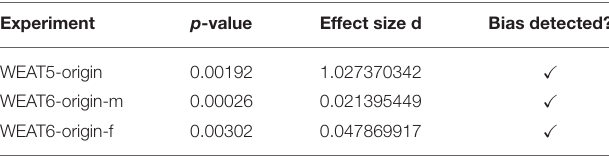
TABLE 8 | Results of the new experiments investigating origin bias in Switzerland on German word embeddings. Experiment Effect size d Bias